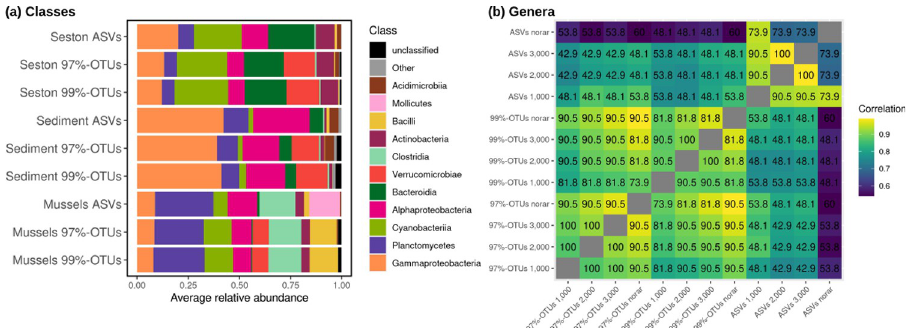
Fig 5. Composition of mussel gut microbiome, sediment, and seston communities found using OTU-based and ASV-based methodologies. (a) The relative abundance of the 11 most common bacterial classes in datasets rarefied to 2,000 sequences/sample. (b) Heatmap representing agreement of the 20 most detected bacterial genera across methodologies and rarefaction levels. Numbers represent the percentage of those 20 genera in common across the compared treatments (‘shared’); color intensity represents overall Spearman’s correlation coefficient of the shared genera between treatments.